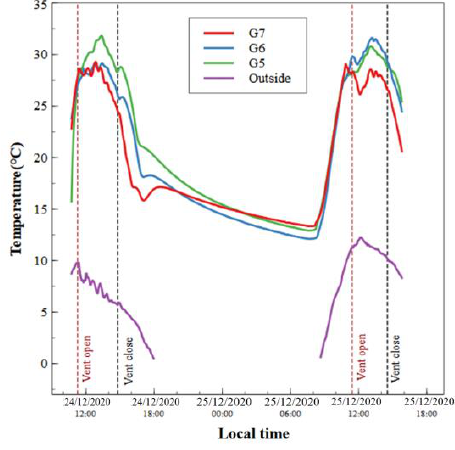
Figure 6. G5, G6, and G7 average temperature data.